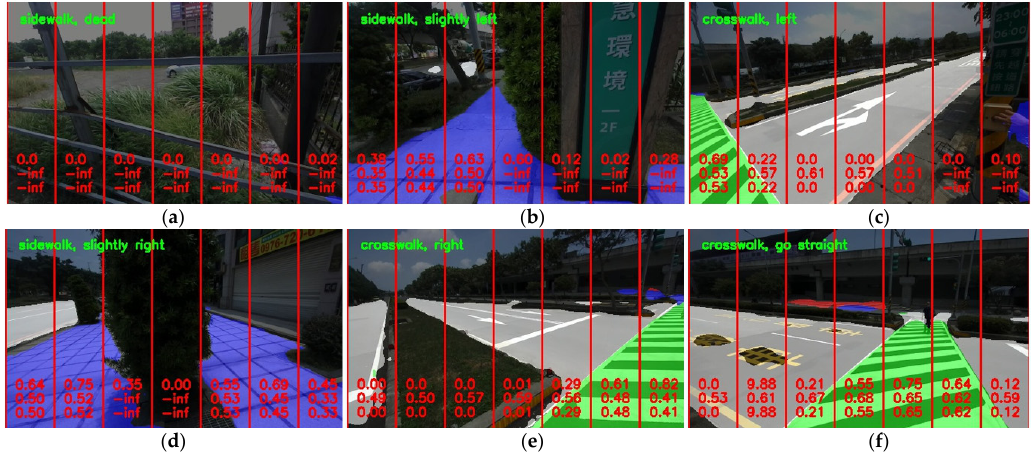
Figure 7. Confidence values for the seven divisions, ( a ) the front view without sidewalks and crosswalks; ( b ) the front view with a sidewalk; ( c ) the front view of the user who is going to the crosswalk from the sidewalk; ( d ) the front view with a tree obstacle on the sidewalk; ( e ) the front view of the user who is crossing the road through crosswalk but looks to the front left; ( f ) the front view of the user who is walking on the crosswalk.